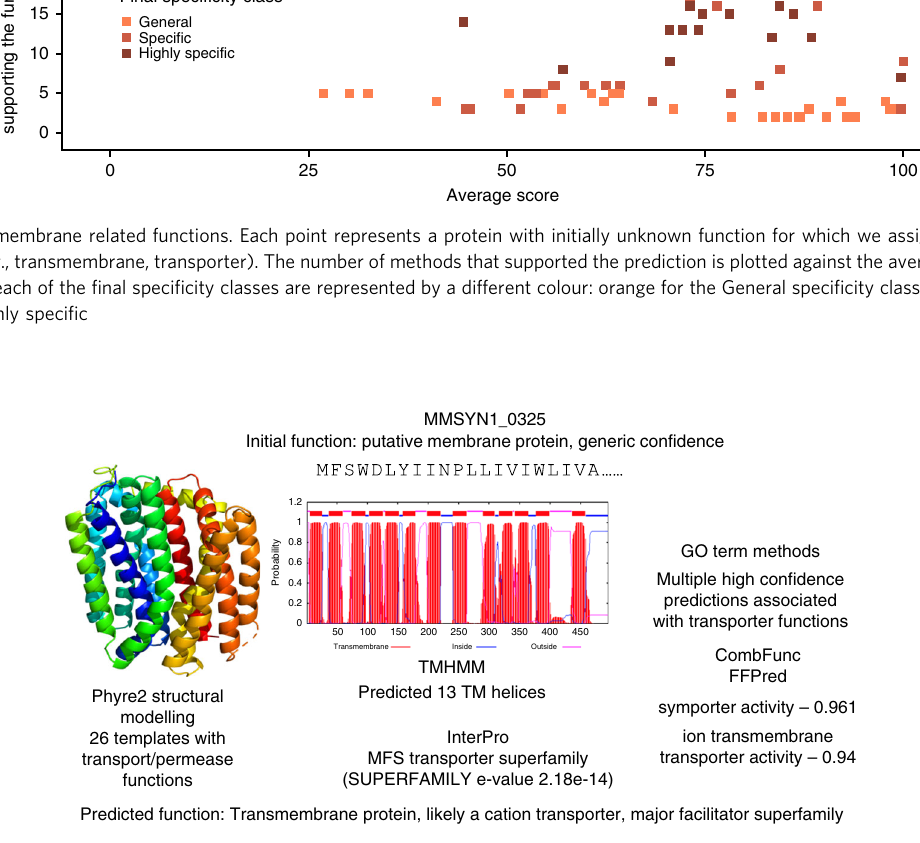
Fig. 10 MMSYN1_0325 is predicted to be a transporter and member of the Major facilitator Superfamily. The results from Phyre2, TMHMM, the combination of GO term prediction methods (numbers shown are probability associated with each function) and InterPro are shown. All of these methods supported a transporter function with Phyre2 and InterPro con fi dently identifying association with the Major facilitator